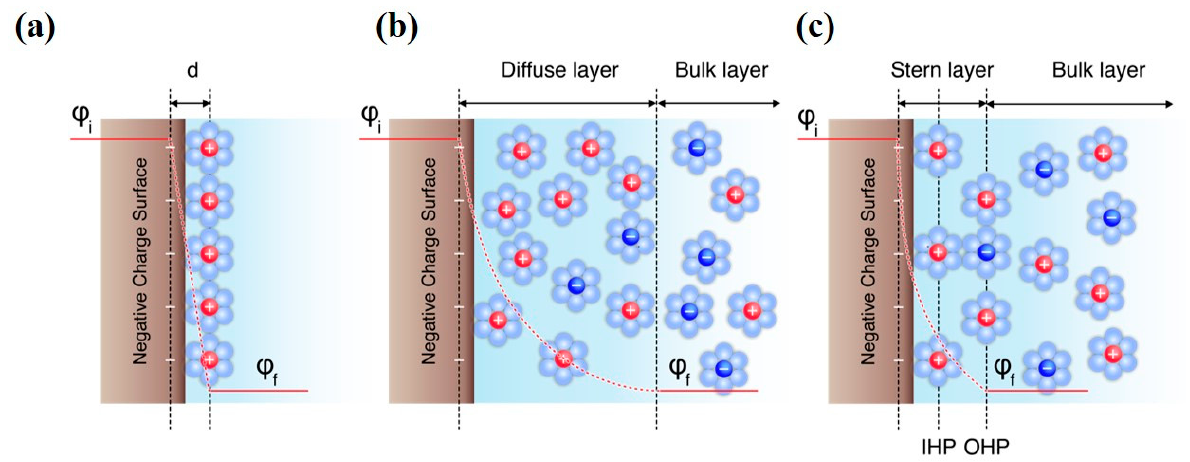
Figure 2. The principle of capacitance model based on the metallic electrode ( a ) Helmholtz model, ( b ) the Gouy-Chapman model or so-called diffuse layer capacitance, and ( c ) the Stern-Otto model.